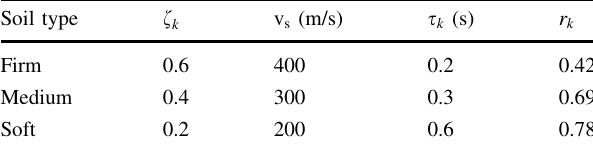
Table 2 Parameters of different sites